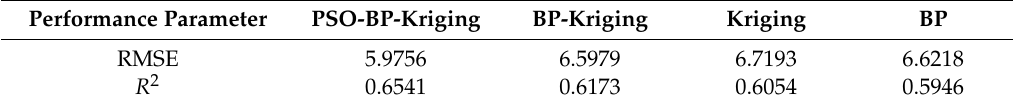
Table 2. Comparison of different model fitting performance.